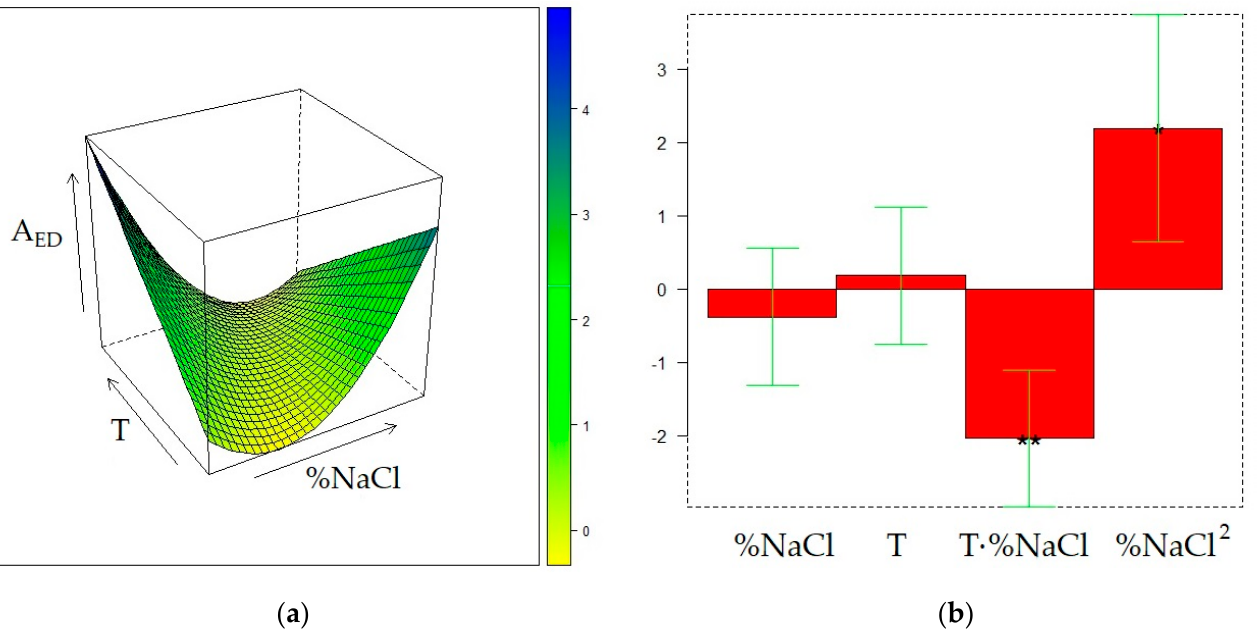
Figure 5. Optimization of HS-SPME profiling of wine volatiles extracted with the DVB/CAR/PDMS fiber: ( a ) response surface for the peak area of ethyl decanoate (A ED ); ( b ) coefficients of the surface model: p < 0.05 (*), p < 0.01(**).